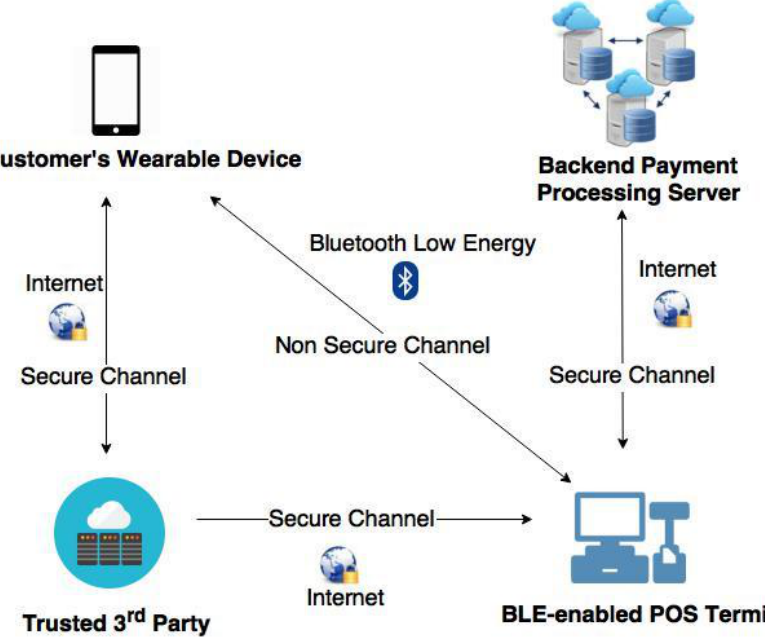
Figure 1. Proposed system architecture for indoor positioning-based mobile payment system.